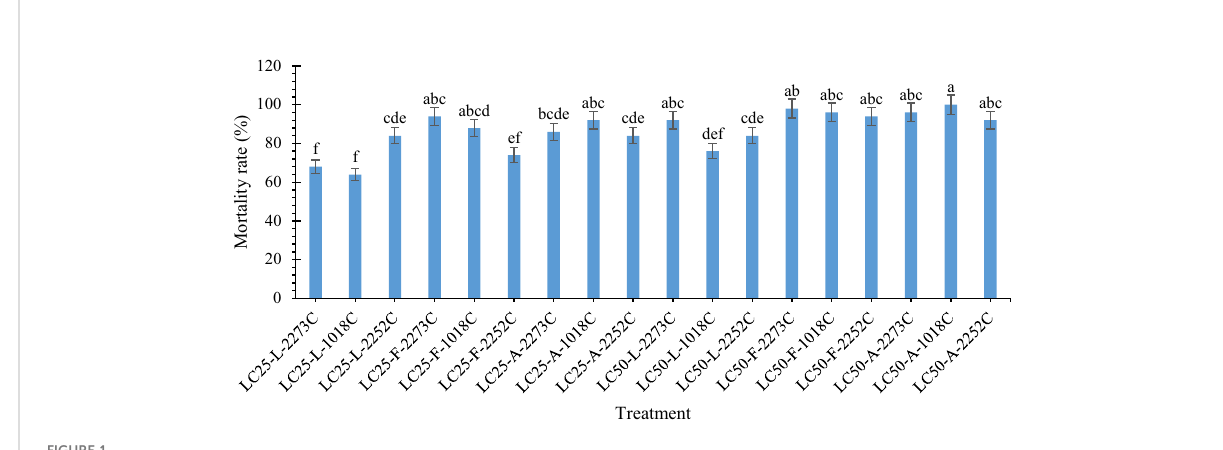
FIGURE 1 Mortality rate (% ± SE) of A. obtectus adults treated with different mixtures of fungal isolates and of plant EOs at LC25 and LC50. In the horizontal axis: ( A. tarragon, A. dracunculus ; L: Lavender, L. angustifolia ; and F: Fennel, F. vulgare